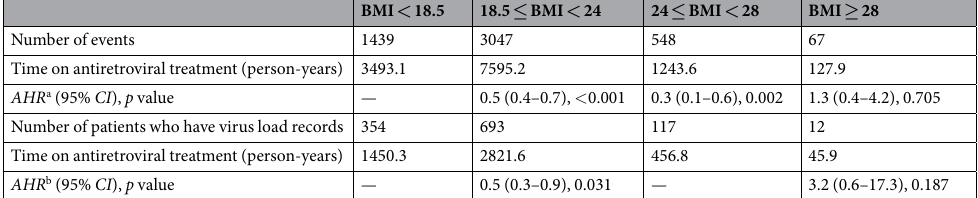
Table 3. Associations between BMI and time to death. AHR a : adjusted by age, gender, marital status, baseline BMI, baseline CD4 T cell count, and clinical disease (including TB infection, Skin lesion, thrush, oral hairy leukoplakia, persistent diarrhoea, continuous or intermittent fever, recurrent severe bacterial infections, disseminated non-tuberculosis bacillus infection, oesophageal candidiasis, extrapulmonary cryptococcal infection, Yersinia pneumocystis pneumonia, disseminated fungal disease, cytomegalovirus infection, extrapulmonary tuberculosis, repeated severe bacterial pneumonia, chronic herpes simplex virus infection, herpes zoster, Toxoplasma encephalopathy, brain lymphoma, and WHO clinical stage). AHR b : adjusted by the viral load on the basis of the AHR a .